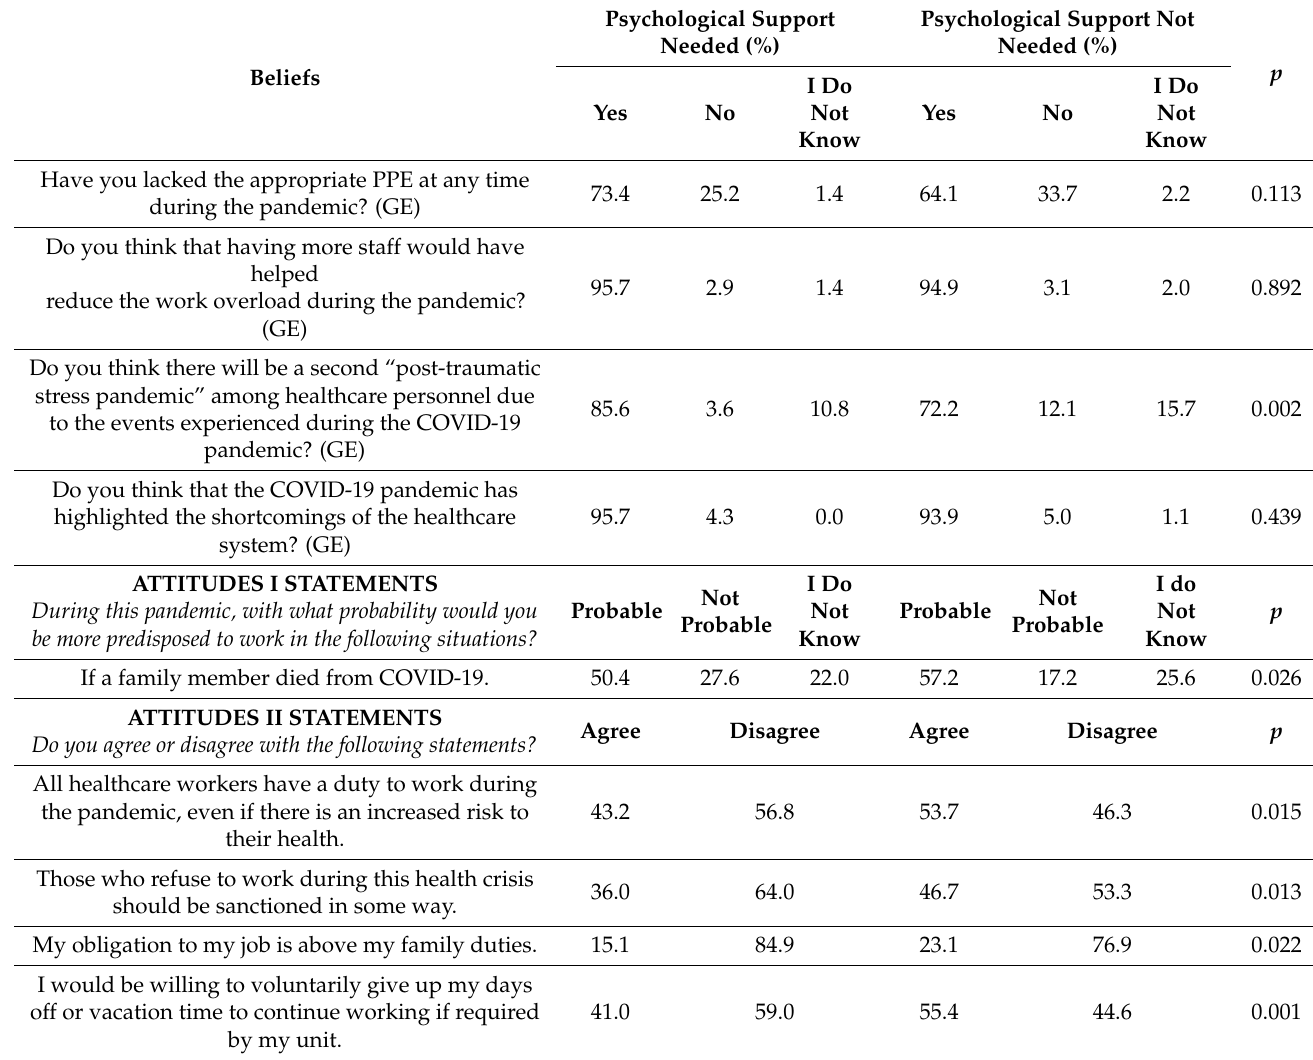
Table A2. Beliefs and attitudes (I and II) of the health professionals according to whether or not they required psychological help (in %). Psychological